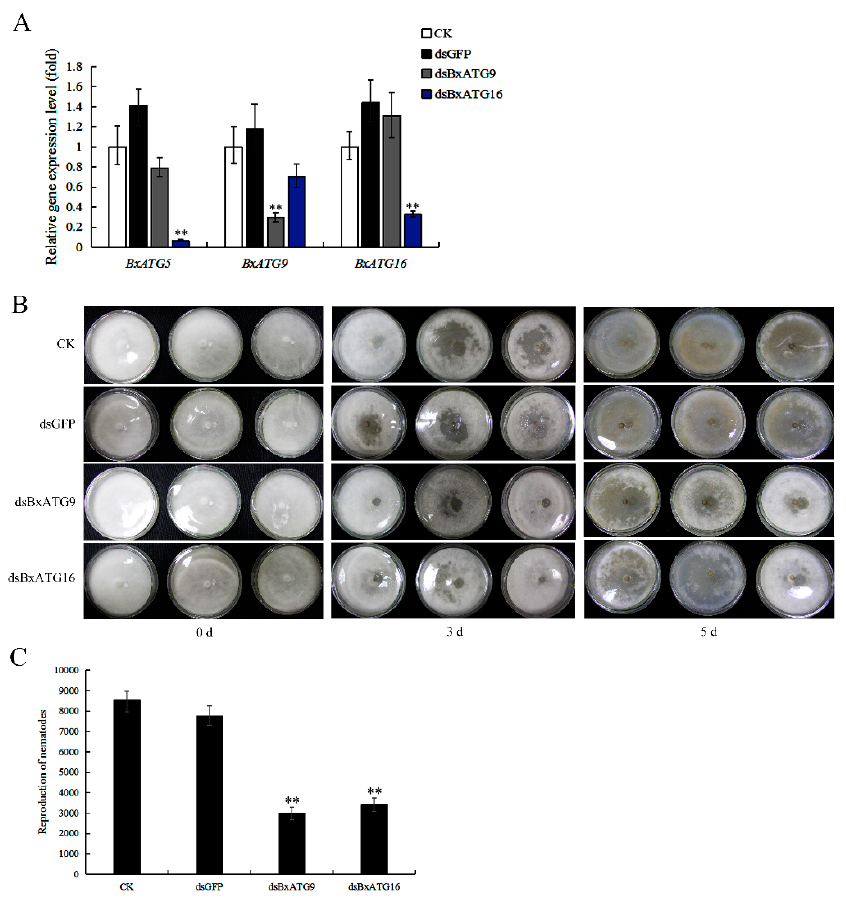
Figure 2. Effects of silencing the autophagy genes BxATG9 , and BxATG16 on feeding and Figure 2. E ff ects of silencing the autophagy genes BxATG9 , and BxATG16 on feeding and reproduction reproduction in PWN. ( A ) Silencing efficiency of BxATG9 and BxATG16 after RNAi with dsBxATG9 in PWN. ( A ) Silencing e ffi ciency of BxATG9 and BxATG16 after RNAi with dsBxATG9 and dsBxATG16 and dsBxATG16 and the effects of RNAi on the expression of other autophagy genes in PWN. PWN and the e ff ects of RNAi on the expression of other autophagy genes in PWN. PWN soaked in dsRNA-free soaked in dsRNA-free solution (CK) and dsGFP were used as controls. The expression level of CK solution (CK) and dsGFP were used as controls. The expression level of CK was set to 100%. ( B ) E ff ects was set to 100%. ( B ) Effects of silencing BxATG9 and BxATG16 on the feeding rates of PWN on potato of silencing BxATG9 and BxATG16 on the feeding rates of PWN on potato dextrose agar (PDA) plates dextrose agar (PDA) plates with Botrytis cinerea . The media darkened with increased feeding. ( C ) with Botrytis cinerea . The media darkened with increased feeding. ( C ) Reproductive assay. Nematodes from di ff erent treatments were isolated from PDA plates using the Baermann funnel method and Reproductive assay. Nematodes from different treatments were isolated from PDA plates using the counted. Data are presented as the mean ± SD. ** p < Baermann funnel method and counted. Data are presented as the mean ± SD. ** p < 0.01.